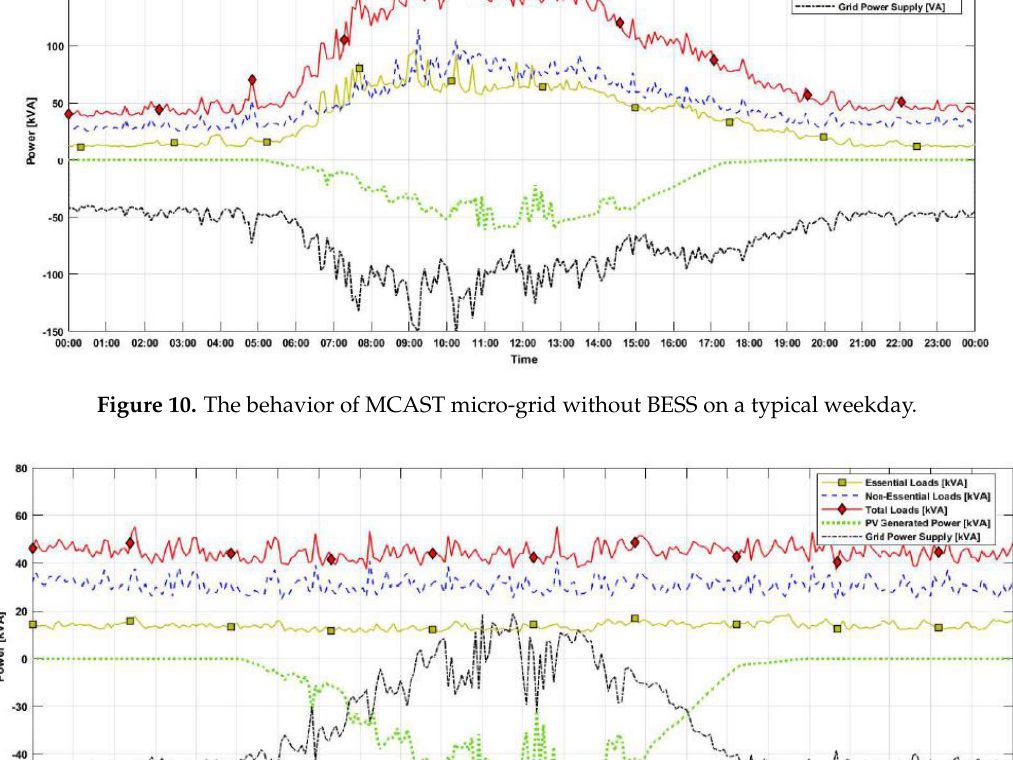
Figure 12. The behavior of MCAST micro-grid with increased PV capacity on a typical weekday. The impact of increasing the PV by the same ratio on a typical weekend is illustrated in Figure 13, where the peak power generation occurs between 11 a.m. and 1 p.m. Since the power consumption is relatively low (about 50 kVA only) for the entire day, energy is transferred back to the grid from 7.30 a.m. until 3 p.m., where the PV power generated is above 40 kVA. This surplus energy could also be utilized locally instead of transferring it back to the main grid by developing the concept of load shifting during some days when the population at MCAST is low.